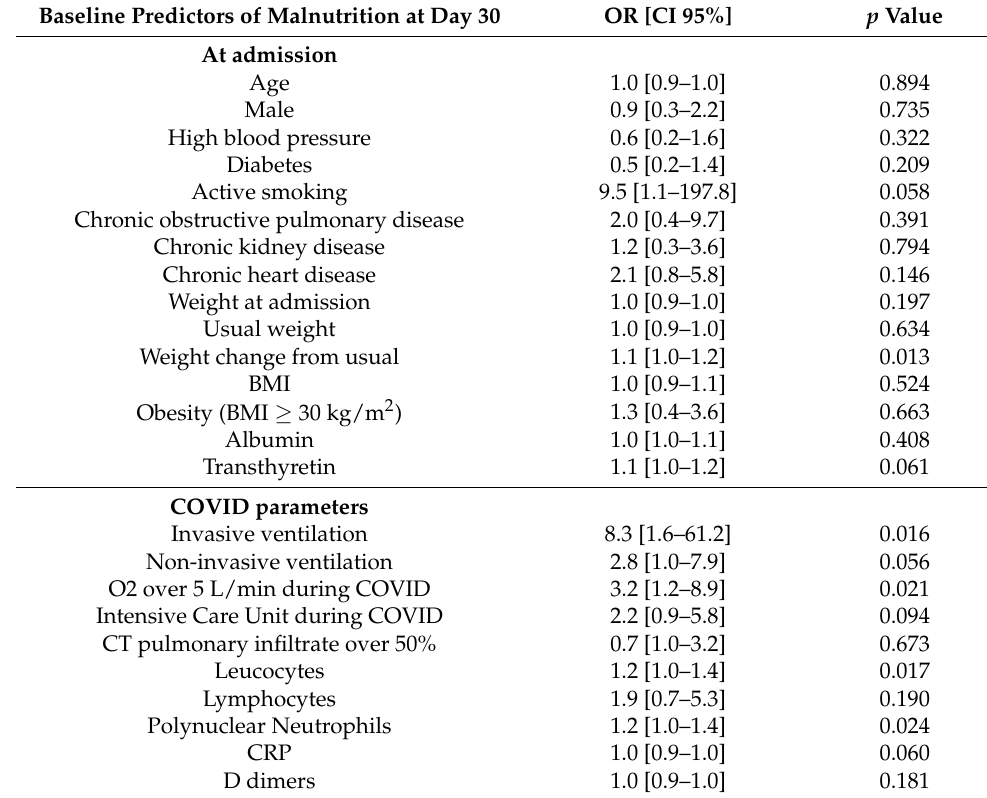
Table 2. Baseline predictors of malnutrition (moderate or severe) according to GLIM nutritional status 30 days after hospital